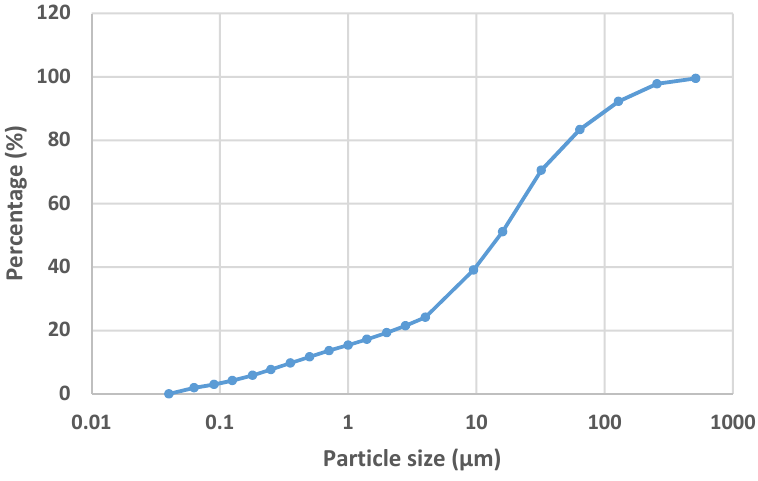
Figure 2. Grain size distribution for the trial landform [51]. The plot was surrounded by concrete borders on three sides to isolate it from runoff from the upslope landform area. On the fourth (downslope) side, a polyvinyl chloride (PVC) half-tube was used to create a channel to capture the surface runoff. This drained to a runoff measurement flume. Both an optical shaft encoder (primary sensor) and pressure transducer (backup sensor) were used to measure the head upstream of the flume’s control section [43]. Rainfall was measured using a tipping bucket pluviometer adjacent to the plot. A turbidity probe (nephelometer) was positioned at the entry to the flume. The initial nephelometer, with a measurement range of 0 to 1000 NTU (nephelometric turbidity units), was replaced in February 2010 with a new probe with a range of 0 to 5000 NTU to also capture higher NTU values. Water samples during events were collected using